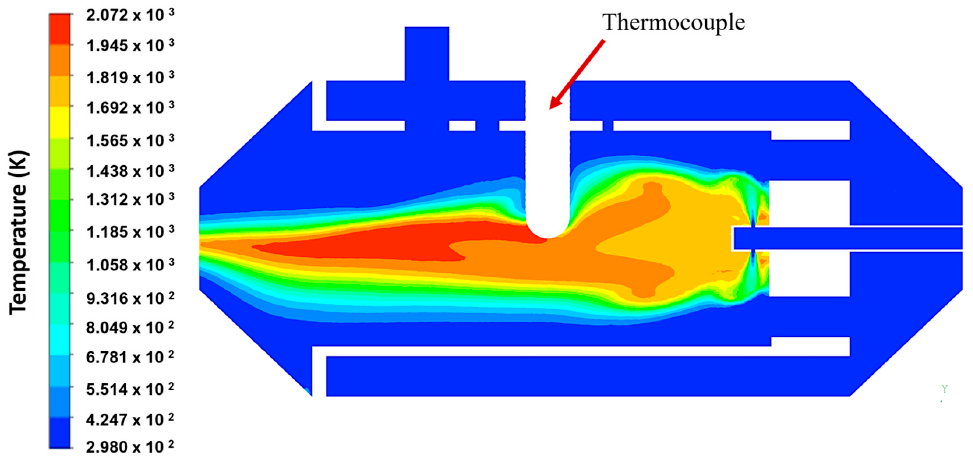
Figure 9. Temperature profile at longitudinal plane at the center of the combustion chamber.